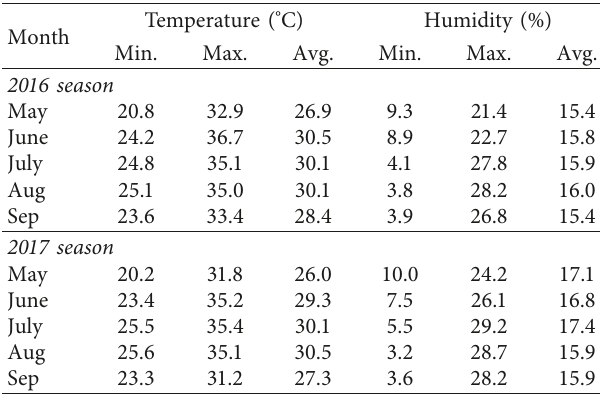
Table 2: Air temperatures ( ° C) and relative humidity (%) during the two growing seasons at the experimental